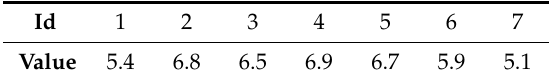
Table 1. The historical data of SOF2.